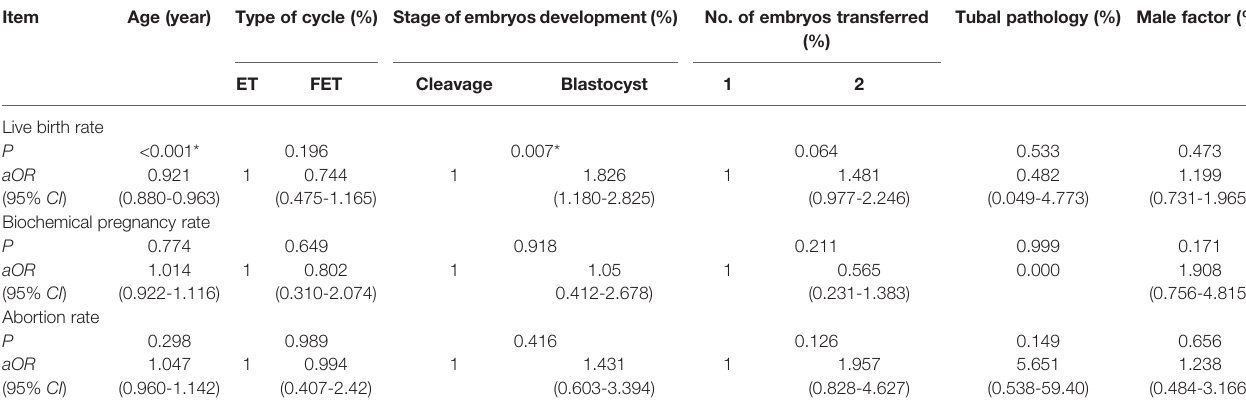
TABLE 3 | The pregnancy outcome of the fourth cycle of patients with three implantation failure by logistic regression